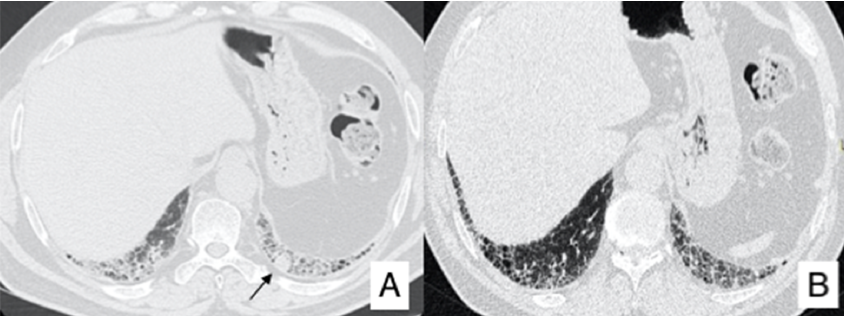
Figure 7. One year later, follow-up HRCT of the same patient in Figure 6, identified a nodule in the left lower lobe (black arrow in ( A ), that was not shown in the first examination ( B